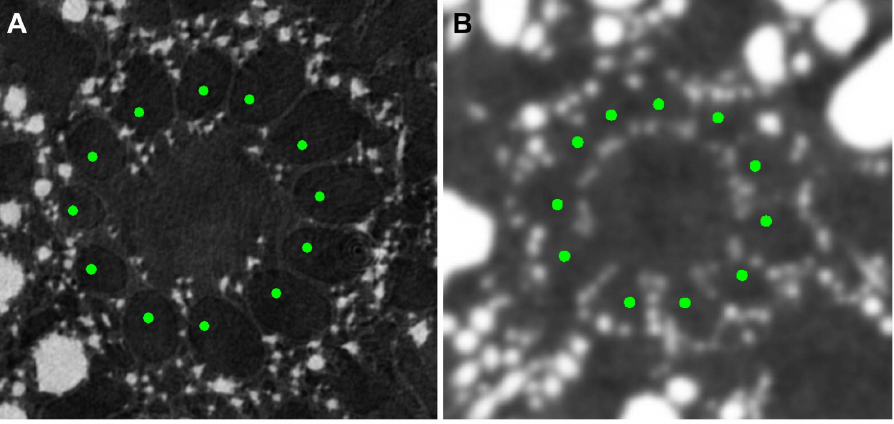
Figure 13. Semi-automatic seed-point initialization in datasets EX (A) and M1 (B).